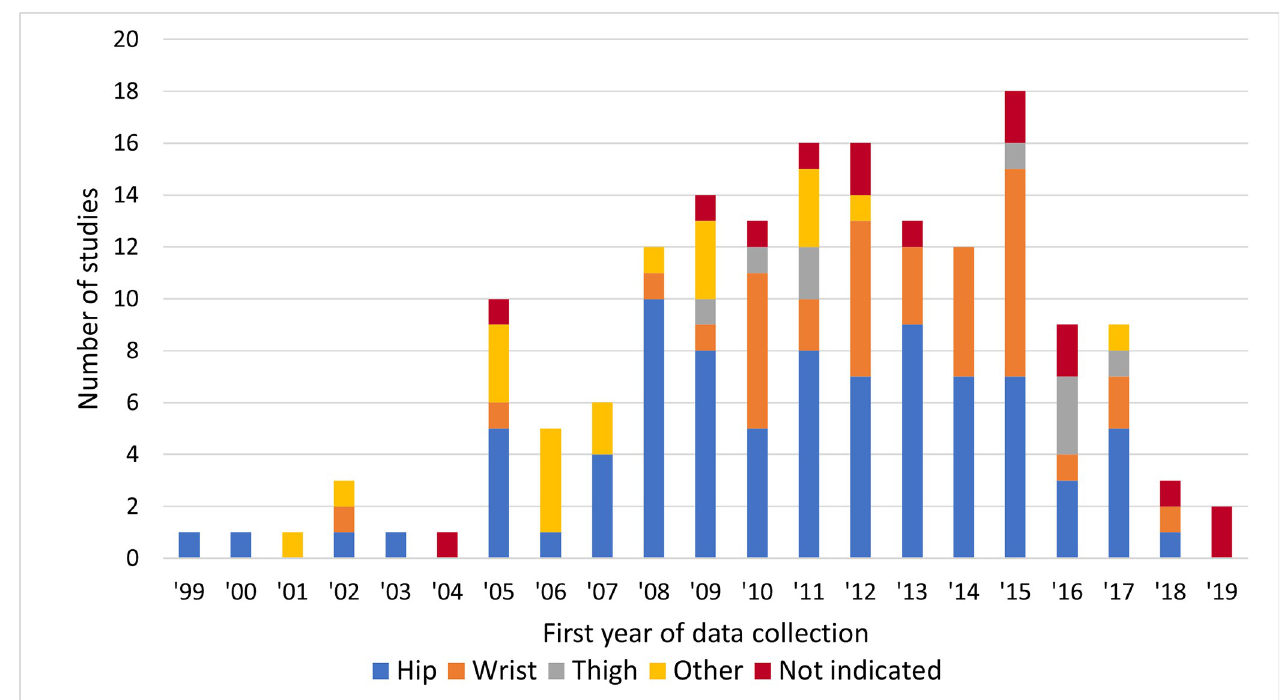
Fig 5. Accelerometer wear location by first year of data collection, graphed at the accelerometer level (n = 166).